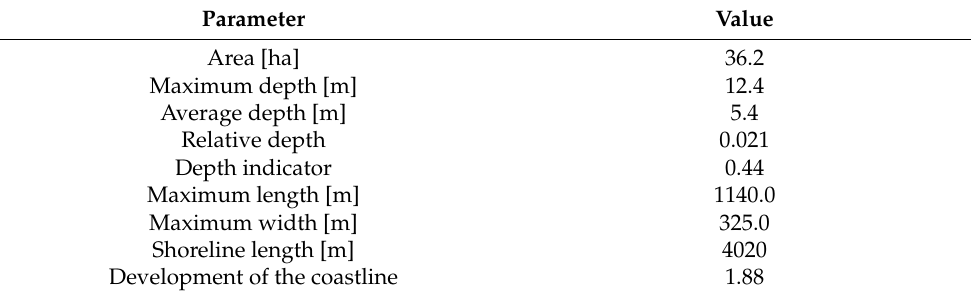
Table 1. Morphometric indicators of Bukwa ł d Lake.